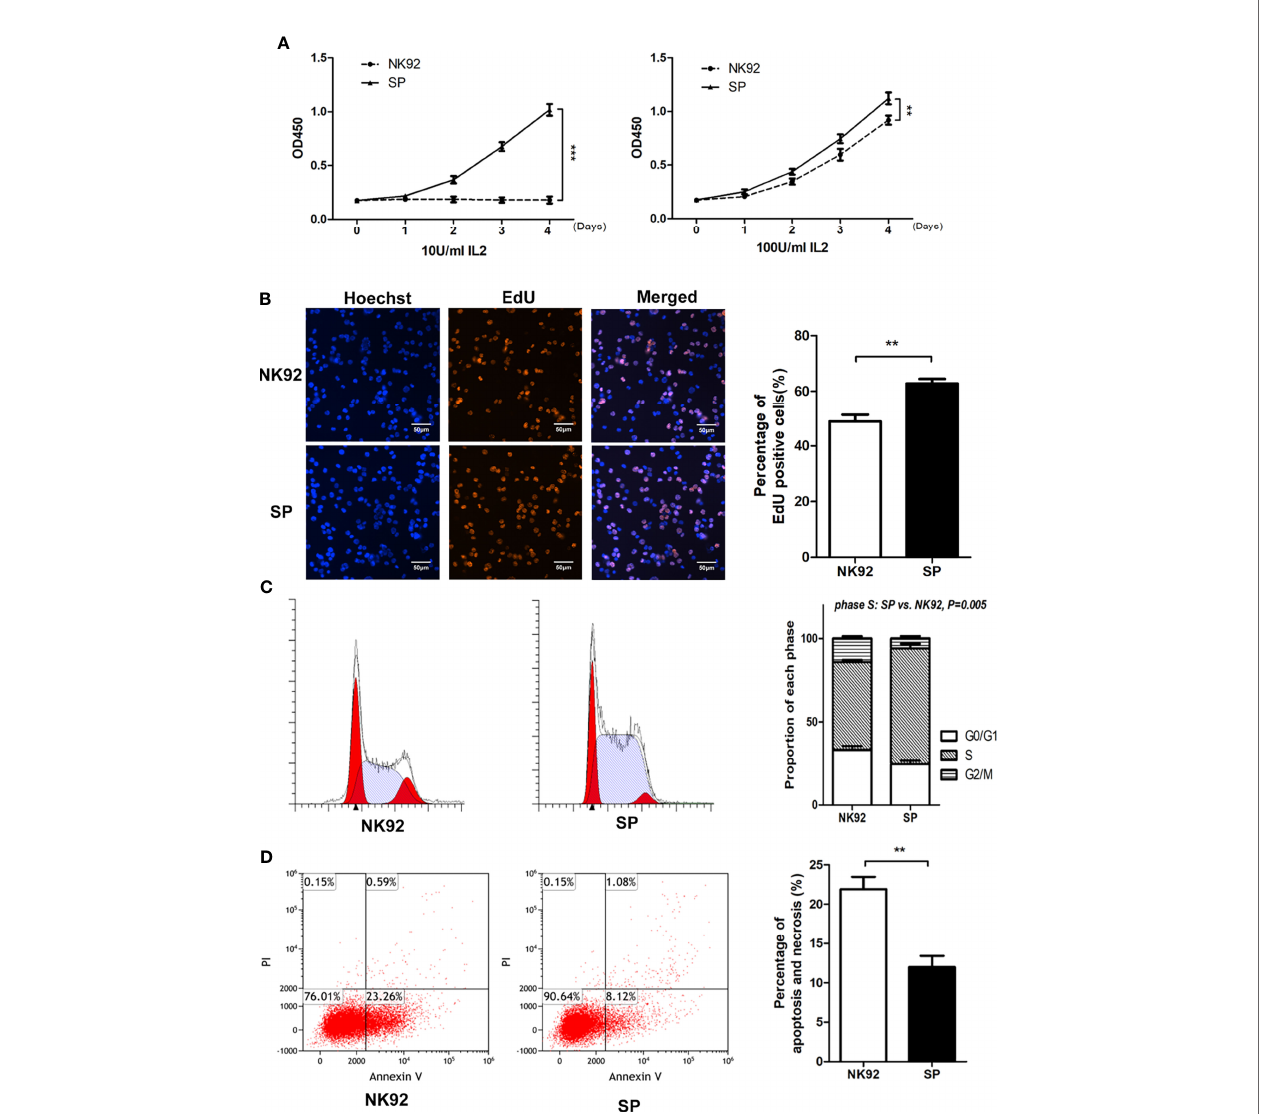
FIGURE 2 | The new CAR-NK-92 (SP) cell line could be stably passaged and expanded independently of exogenous IL-2. (A) Short term proliferation of SP and NK92 cells exposed to 10 U/mL IL-2(left) and 100 U/mL IL-2 (right) supplements. (B) 5-Ethynyl-2 ’ -deoxyuridine (EdU) assay and (C) cell cycle analysis were performed using SP cells and NK92 cells cultured with the 100 U/mL IL-2 supplement. (D) Shown is the percentage of apoptotic cells was detected by FCM after culturing NK92 and SP cells in PBS for 8 hours. The left sides of panels (B – D) show a representative sample image of the experimental results, and the right side shows the statistical results of three parallel experiments expressed as mean ± SEM (n = 3, ** P < 0.01, *** P <